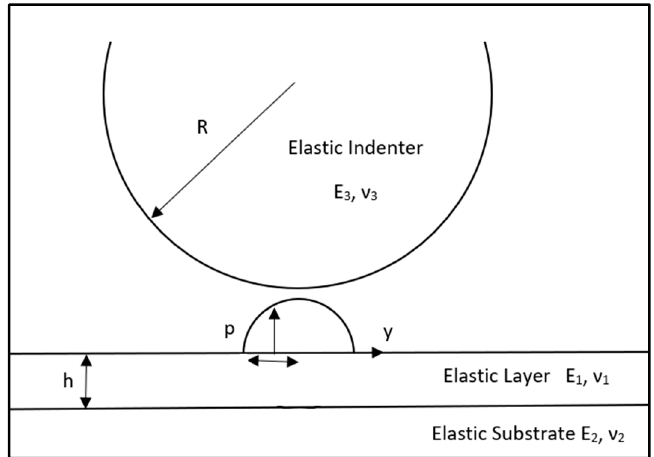
Figure 3. Description of approach of coated and non-coated gear.